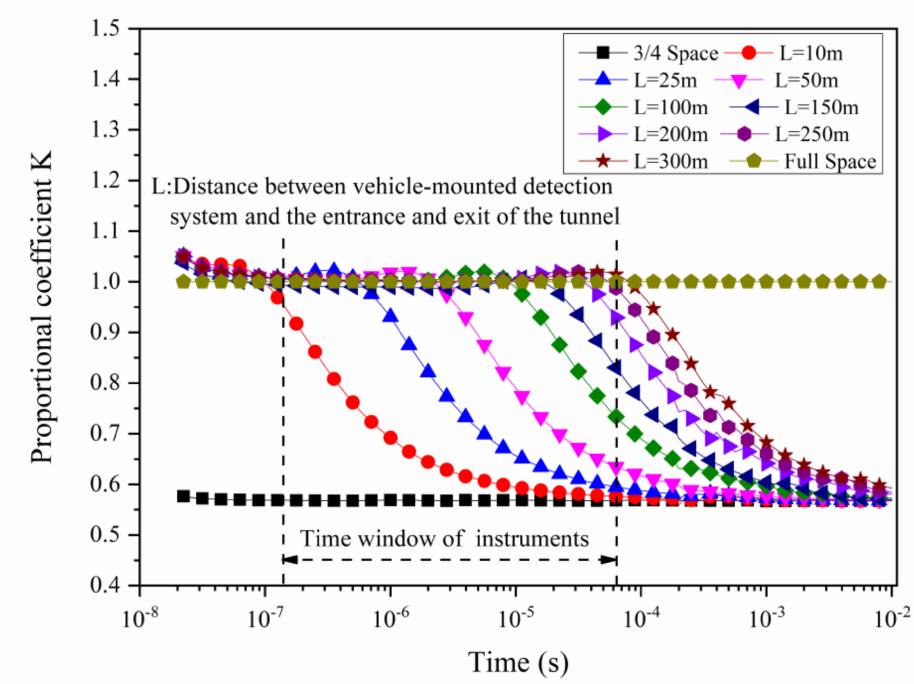
Figure 7. Space proportional coefficient under different